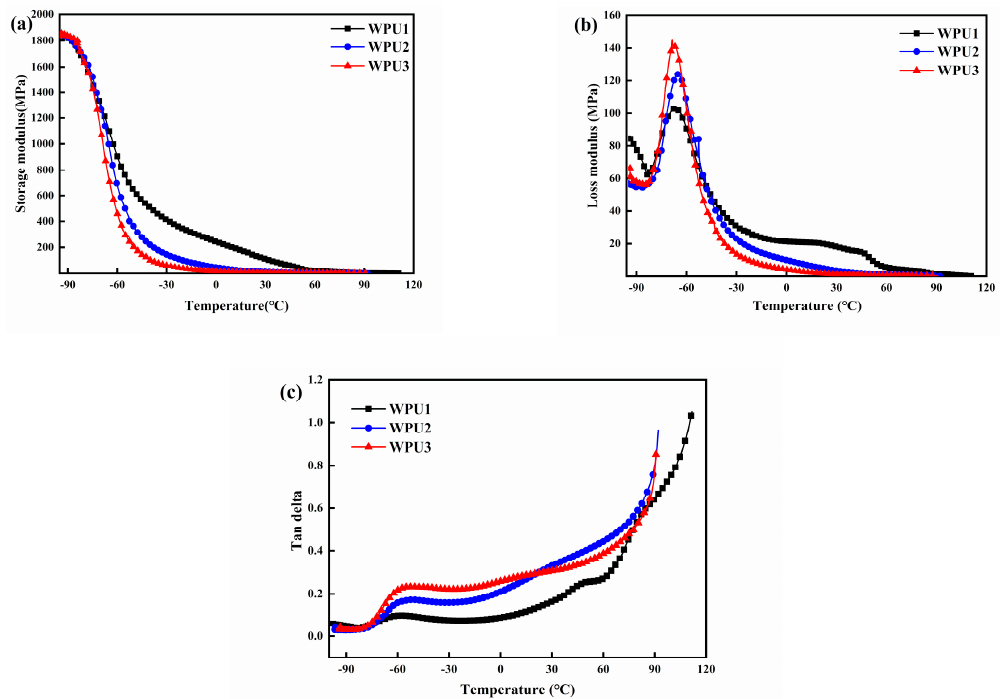
Figure 4. ( a ) Storage modulus, ( b ) loss modulus and ( c ) tan delta of WPU-SS samples with different contents of SS as a function of temperature.